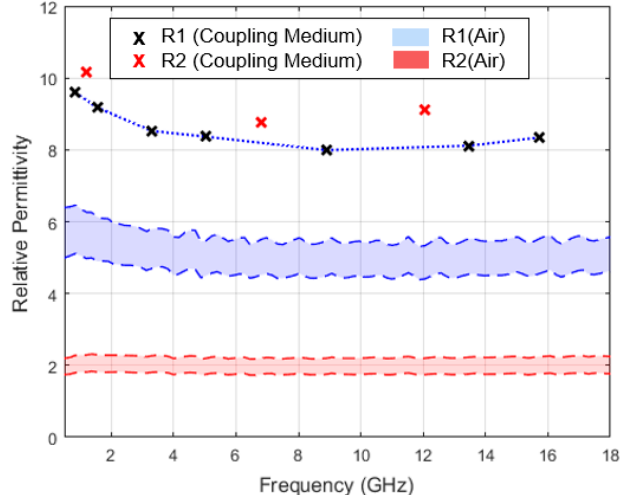
Figure 11. Evaluation of the performance of the method based on coupling media application over two different tooth surfaces. Measurements were conducted over smooth (R1) and concave (R2) surfaces of a molar root. Range of relative permittivity recorded without the application of coupling media (shaded bands) demonstrates a clear difference between tooth–probe contact for the chosen measurement locations. The estimated relative permittivity, with the application of coupling media, is represented by crosses.